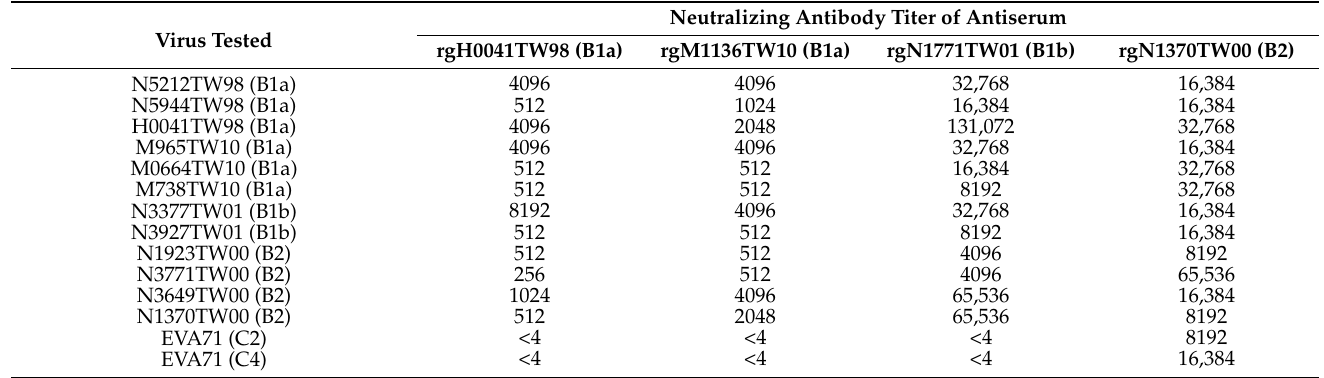
Table 2. Neutralizing antibody titers of rgCVA16 -induced antisera against various CVA16 and EVA71